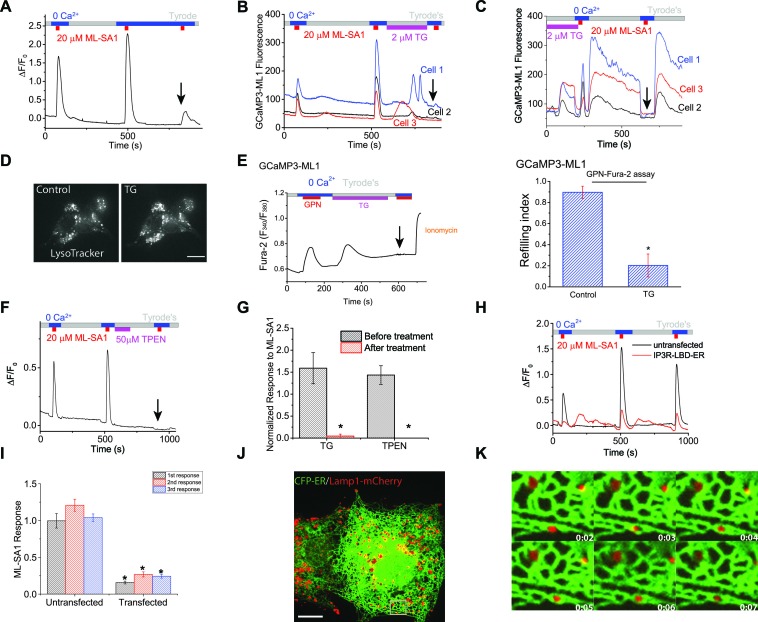
Lysosomal Ca2+ refilling is dependent on the endoplasmic reticulum (ER) Ca2+.(A) Ca2+ refilling of lysosomes requires external Ca2+. (B) Dissipating the ER Ca2+ gradient using SERCA pump inhibitor Thapsigargin (TG) blocked lysosomal Ca2+ refilling in HEK-GCaMP3-ML1 cells. Three representative cells from among 30–40 cells on one coverslip are shown. Note that Ca2+ release from the ER through passive leak revealed after blocking SERCA pumps was readily seen in HEK-GCaMP3-ML1 cells, presumably due to the close proximity between lysosomes and the ER (Kilpatrick et al., 2013). (C) The effect of acute application of TG (2 μM) on the naïve ML-SA1 response and lysosomal Ca2+ refilling in HEK-GCaMP3-ML1 cells. Application of TG did not affect the naïve, initial response to ML-SA1, but did abolish the refilled response (see arrow). Control naïve response 1.39 ± 0.09 (n=3); Naïve response after TG 1.08 ± 0.07 (n=3); p=0.2024). (D) LysoTracker staining was not reduced by TG (2 μM). (E) Representative Ca2+ imaging trace and statistical data (right panel; Figure 2—source data 1) show that TG application reduced the second responses to GPN compared to the control shown in Figure 1D. (F) Chelating ER Ca2+ using 2-min TPEN treatment blocked Ca2+ refilling of lysosomes. (G) TG (p=0.008; n=5) and TPEN (p=0.001; n=5) abolished Ca2+ refilling of lysosomes (Figure 2—source data 1). (H) In HEK-GCaMP3-ML1 cells that were transiently transfected with the IP3R-ligand binding domain with ER targeting sequence (IP3R-LBD-ER), which significantly reduces basal [Ca2+]ER (see Figure 2—figure supplement 2E), ML-SA1 responses were reduced, compared to untransfected cells on the same coverslip. (I) The 1st (p=0.0014), 2nd (p=0.0004), and 3rd responses (p<0.0001) of GCaMP3-ML1 cells transfected with the IP3R-LBD-ER were significantly reduced compared to untransfected cells on the same coverslip (n=5; Figure 2—source data 1). (J) Lysosomes (labeled with Lamp1-mCherry) interact closely with the ER (labeled with CFP-ER). (K) Time lapse zoomed-in images of a selected region from J show the dynamics of ER-lysosome association (see an example in the boxed area). Panels A, F, H are the average responses of 30–40 cells from one representative experiment. The data in panel G represent mean ± SEM from five independent experiments.DOI:
http://dx.doi.org/10.7554/eLife.15887.00810.7554/eLife.15887.009Figure 2—source data 1.Comparisons of GPN (E) and ML-SA1 responses (G, I) under different pharmacological and genetic manipulations (Figure 2E,G,I).Comparisons of responses to ML-SA1 (E) and GPN (G) (Figure 2—figure supplement 1E,G).